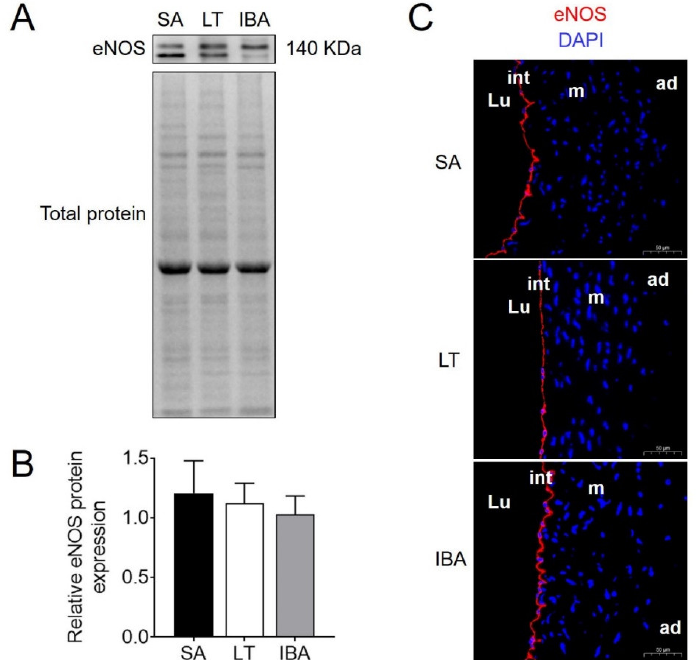
Figure 10. The protein expression level and localization of eNOS in thoracic aorta. ( A ) Typical West- ern blot image of eNOS protein. ( B ) Statistical image of protein expression of eNOS in thoracic aorta from SA, LT and IBA squirrels, mean ± SEM, n = 5. ( C ) Immunofluorescence staining of eNOS in thoracic aorta, scale bar = 50 μm. DAPI (blue) labels the nucleus, and CY3 (red) labels the eNOS protein. SA: summer active, LT: late torpor, IBA: interbout arousal, Lu: lumen, int: intima, m: media,